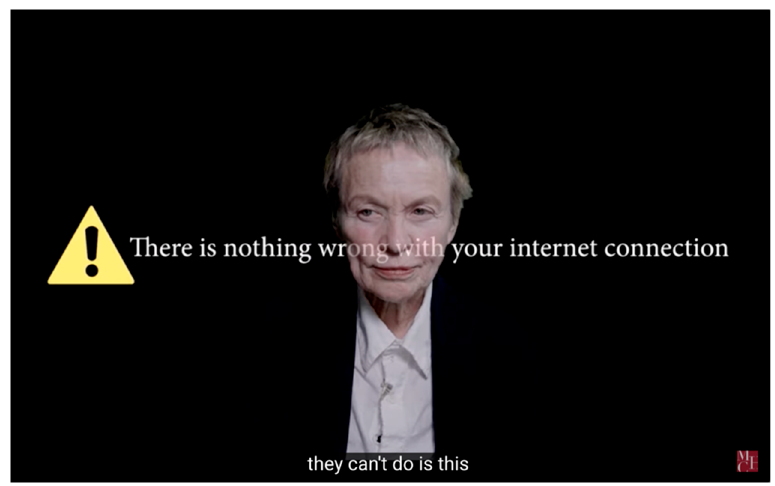
Figure 4. Anderson, Laurie. Still from The Road part 4 of Norton Lectures: Spending the War Without You. October 2021.